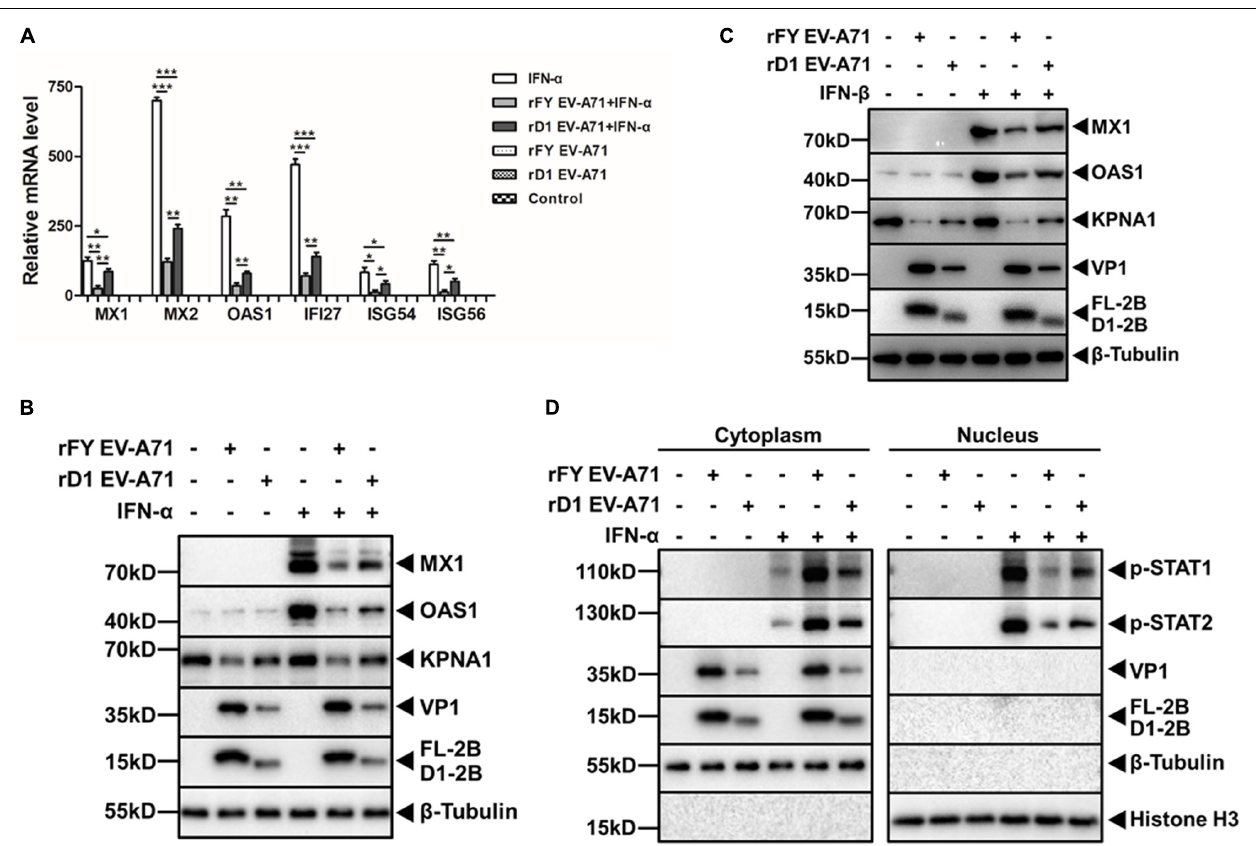
FIGURE 10 | Decreased inhibitory effect on type I IFN response stimulated by IFN- α / β in rD1 EV-A71-infected cells. (A) Induction of ISGs in rD1-infected cells. HeLa cells were infected with rFY or rD1 EV-A71 for 24 h, followed by treatment with or without IFN- α (25 ng/ µ L) for another 2 h. Total RNA was prepared from the cells for real-time RT-PCR to measure relative levels of the ISG gene transcripts. Values represented mean ± SD from triplicates of independent experiments. t tests were conducted on values from different groups. * P < 0.05; ** P < 0.01; *** P < 0.001. (B,C) Decreased reduction of ISGs and KPNA1 in rD1-infected cells. HeLa cells were infected with rFY or rD1 EV-A71 for 24 h, followed by treatment with or without IFN- α (B) or IFN- β (C) (25 ng/ µ L) for another 2 h. Cell lysates were prepared for western blot analyses with antibodies for MX1, OAS1, or KPNA1. (D) Increased translocation of p-STAT1/2 into the nucleus in rD1-infected cells. HeLa cells were infected with rFY or rD1 EV-A71 for 24 h, followed by stimulation with IFN- α (25 ng/ µ L) for another 30 min. The cytosolic and nuclear fractions were prepared from the cells for western blot analyses with antibodies for p-STAT1 or p-STAT2. β -tubulin and histone H3 were detected as loading controls for cytosolic and nuclear fractions,